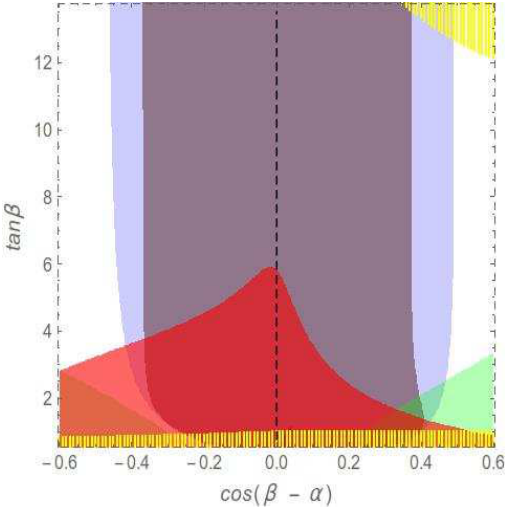
Figure 6 . Little Higgs model based on SU(6) / Sp(6). Colour coding is the same as in figure 1. c β t β plane from both directions. For a composite 2HDM based on coset SO(6) / SO(4) α − − SO(2) [86–88] the allowed range of cos( β